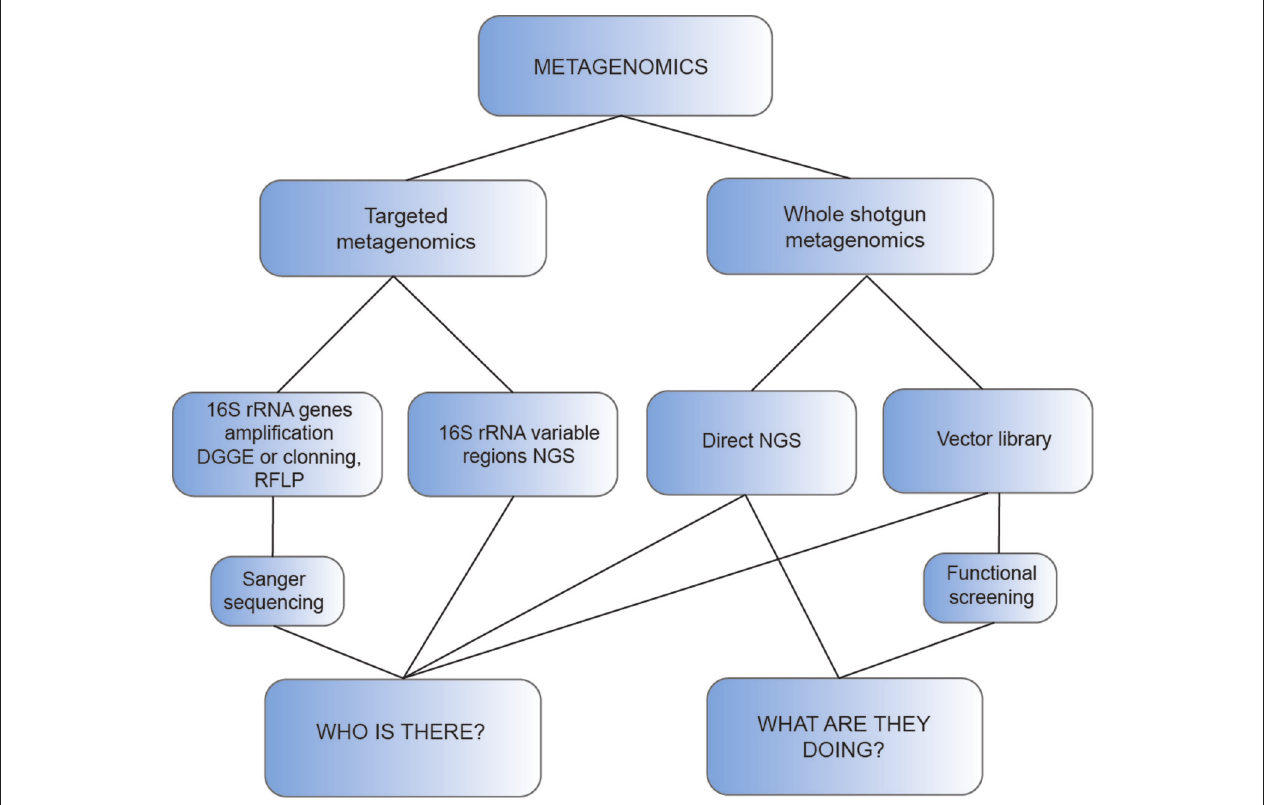
FIGURE 1 | Schematic representation of the main approaches used for metagenomic analysis of thermophiles.